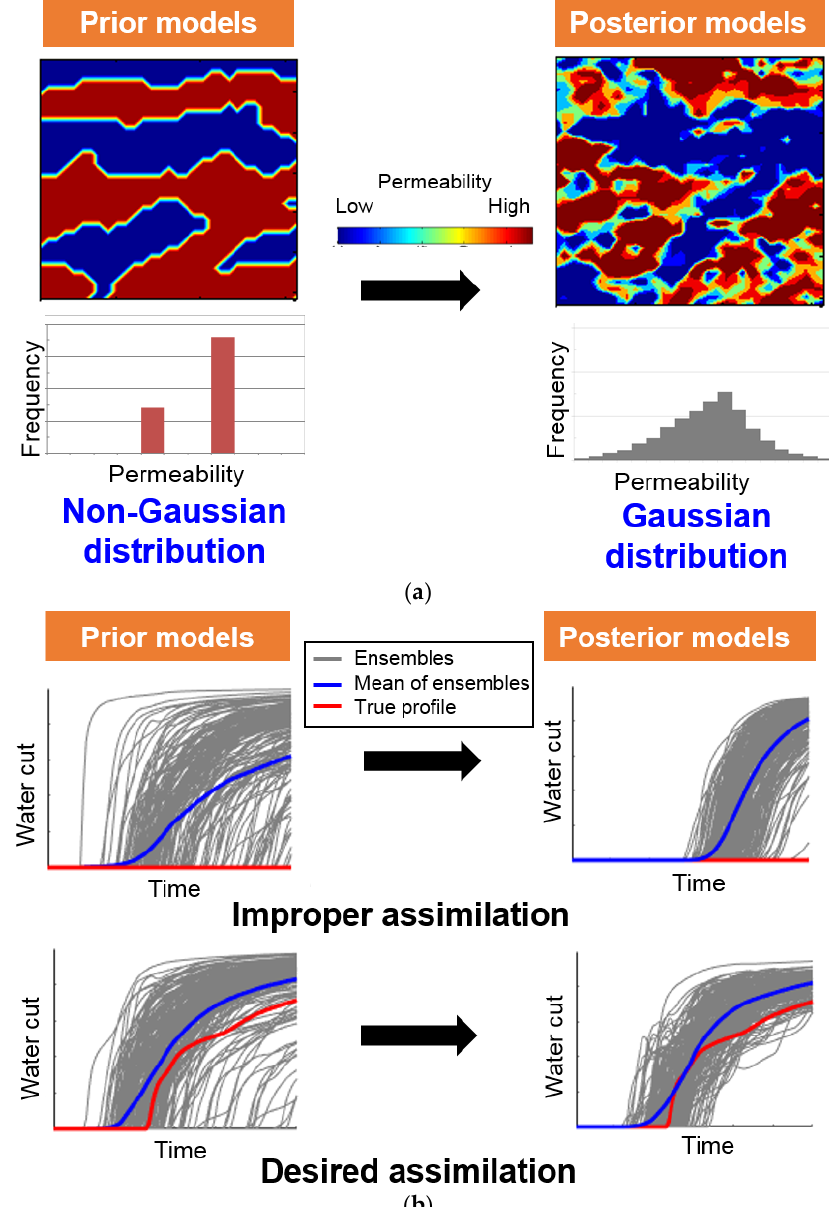
Figure 1. Examples of unreliable results after assimilating the dynamic data through ensemble-based data assimilation: ( a ) The reservoir properties of the true case follow a non-Gaussian distribution (bimodal distribution), but the assimilated result shows a Gaussian distribution; ( b ) When prior models (grey lines) contain the true performance (red line), ensemble-based methods estimate the reliable assimilation for their mean values to converge the true profile.